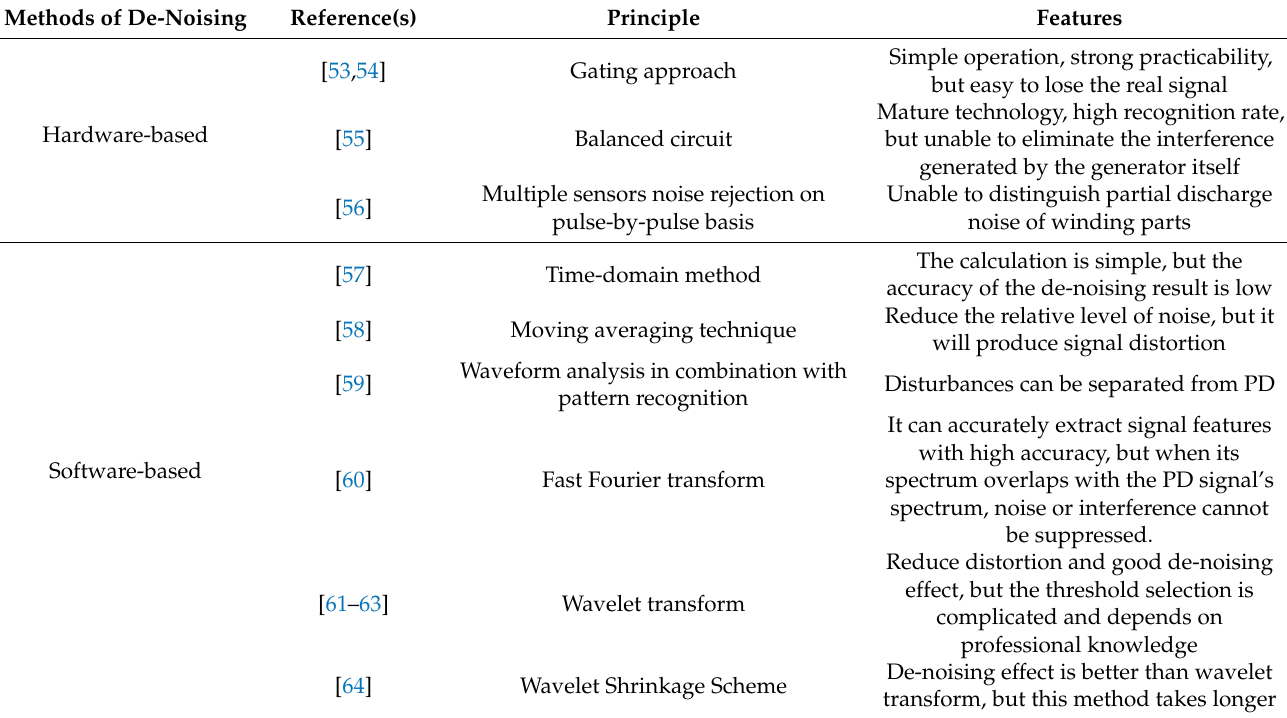
Table 3. Conclusion of de-noising method of partial discharge